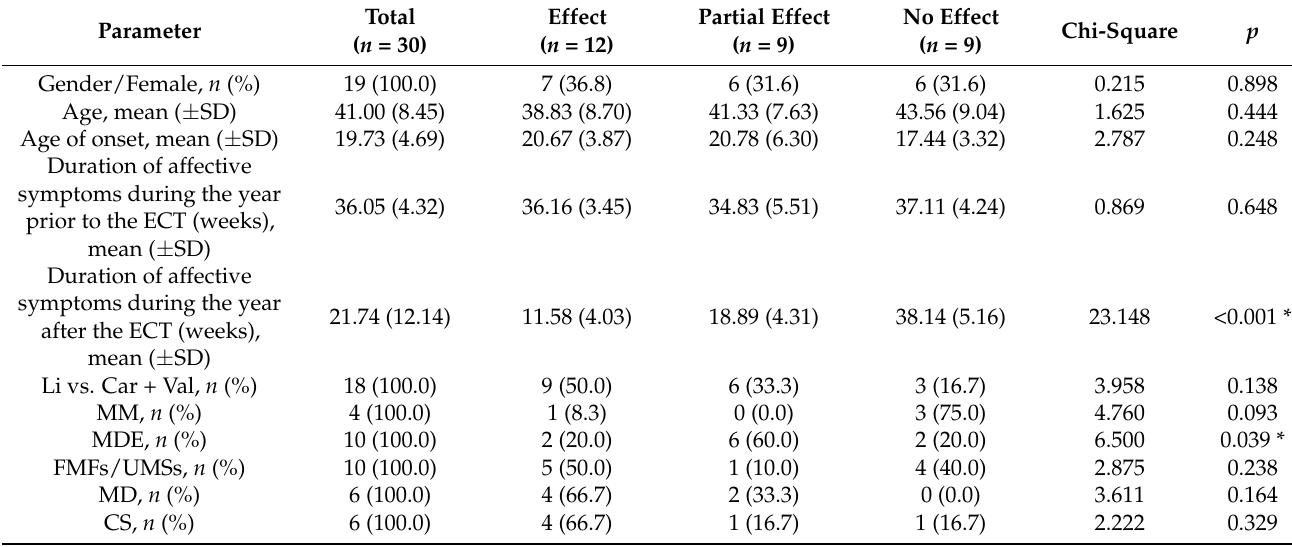
Table 4. Demographic and clinical characteristics of groups by the level of response to long-term mood stabilizer